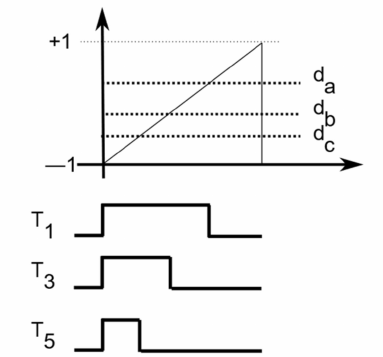
Figure 2. PWM generation from the control signals.